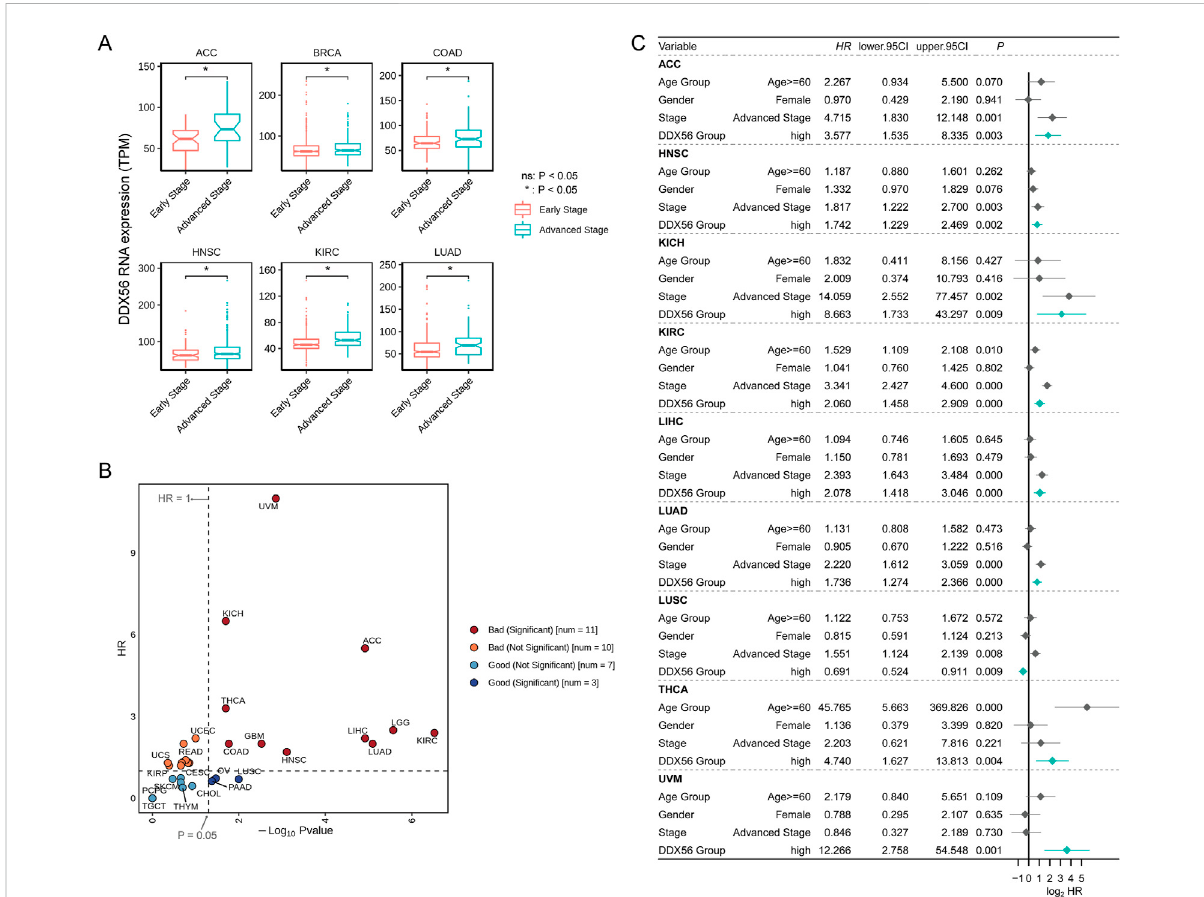
PrognosticvalueofDDX56invariouscancers. (A) BoxplotsshowingRNAexpressionlevelsof DDX56 atdifferentclinicalstages.Foreachtumor, stages Ⅰ and Ⅱ were classi fi ed as early stage; stages Ⅲ and Ⅳ were classi fi ed as advanced stage. (B) Scatter plot showing outcomes in cancer patients with different DDX56 expression levels. Statistics were obtained by univariate Cox regression analysis. (C) Forest plot showing the results of multivariate Cox regression for multiple tumor types. Abbreviations: ACC, adrenocortical carcinoma; BRCA, breast invasive carcinoma; COAD, colonadenocarcinoma; GBM, glioblastoma multiforme;HNSC,head and necksquamouscell carcinoma;KICH, kidney chromophobe; KIRC,kidney renal clear cell carcinoma; LIHC, liver hepatocellular carcinoma; LUAD lung adenocarcinoma; LUSC, lung squamous cell carcinoma;